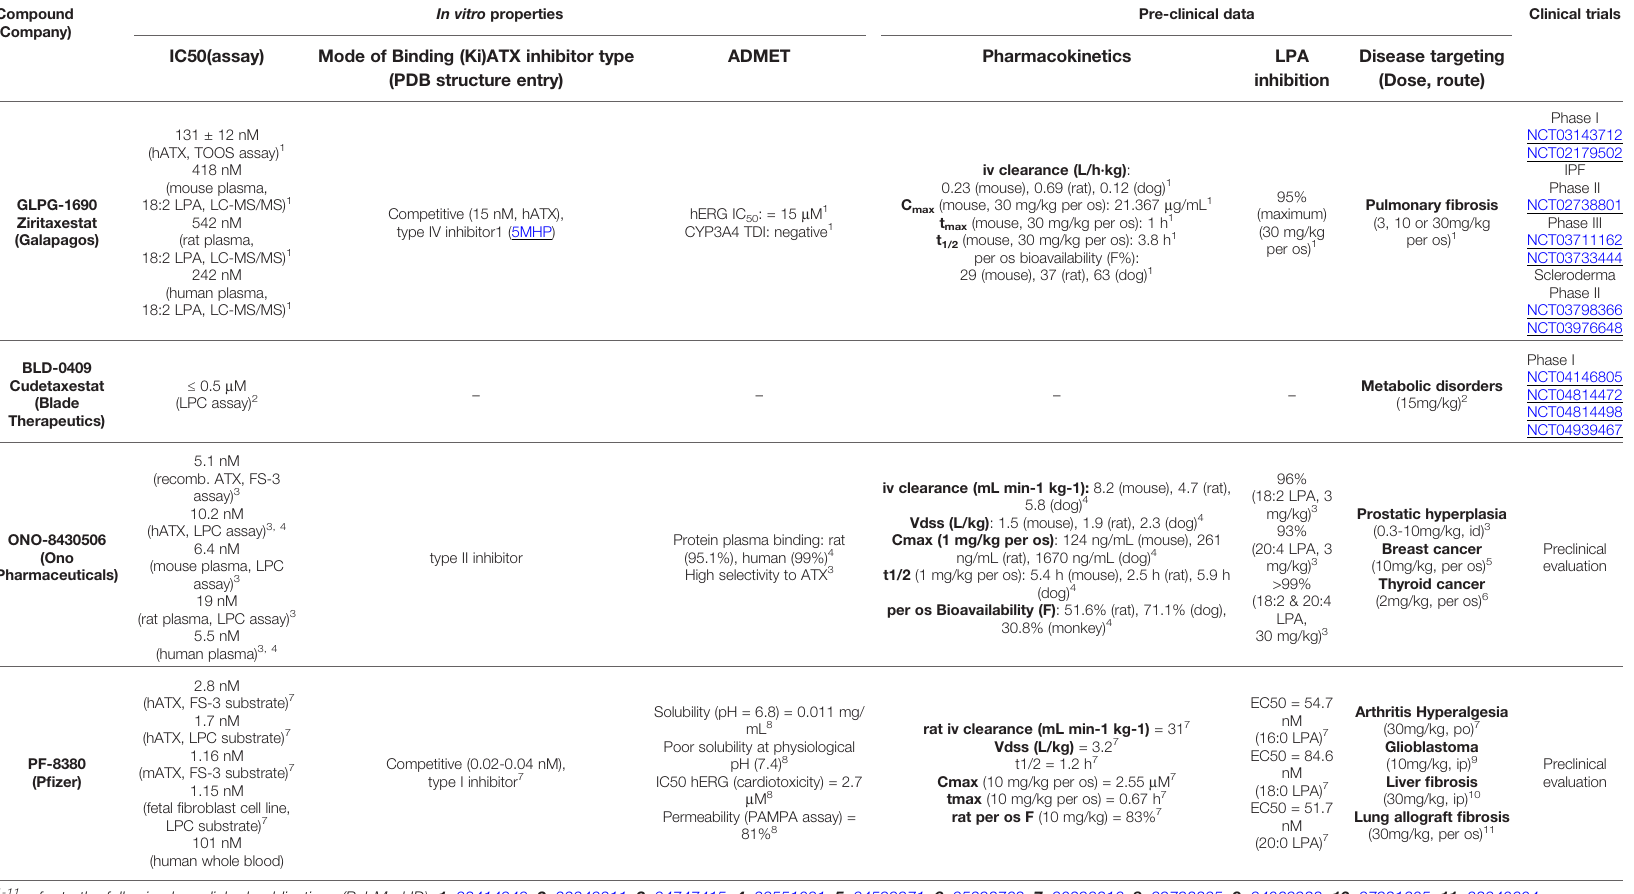
TABLE 3 | Representative small molecules targeting ATX in late-stage preclinical and clinical